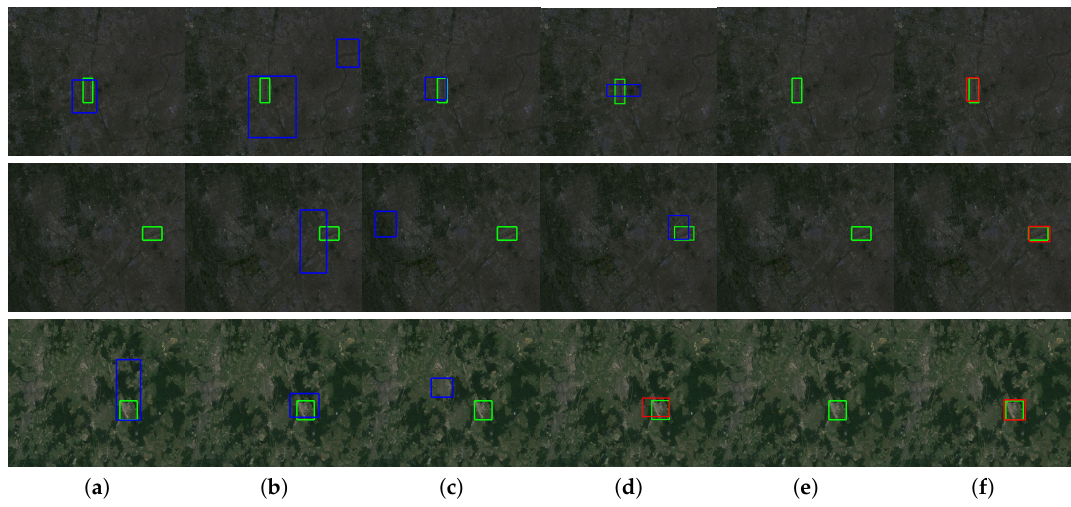
Figure 13. Detection results at different illuminations. The true positives, false positives, and ground-truths are indicated by red, blue and green rectangles, respectively. ( a ) BU and TD saliency [12]. ( b ) Saliency and CRF [13]. ( c ) HRL [1]. ( d ) CNN with USB-BBR [26]. ( e ) Faster R-CNN [19]. ( f ) our network.